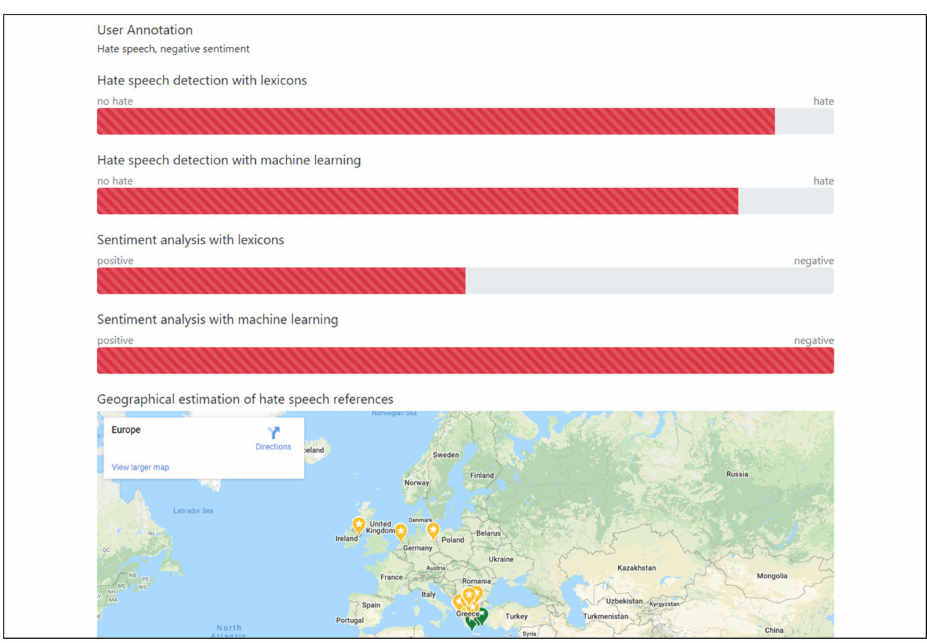
Figure 4. The analysis screen of the PHARM